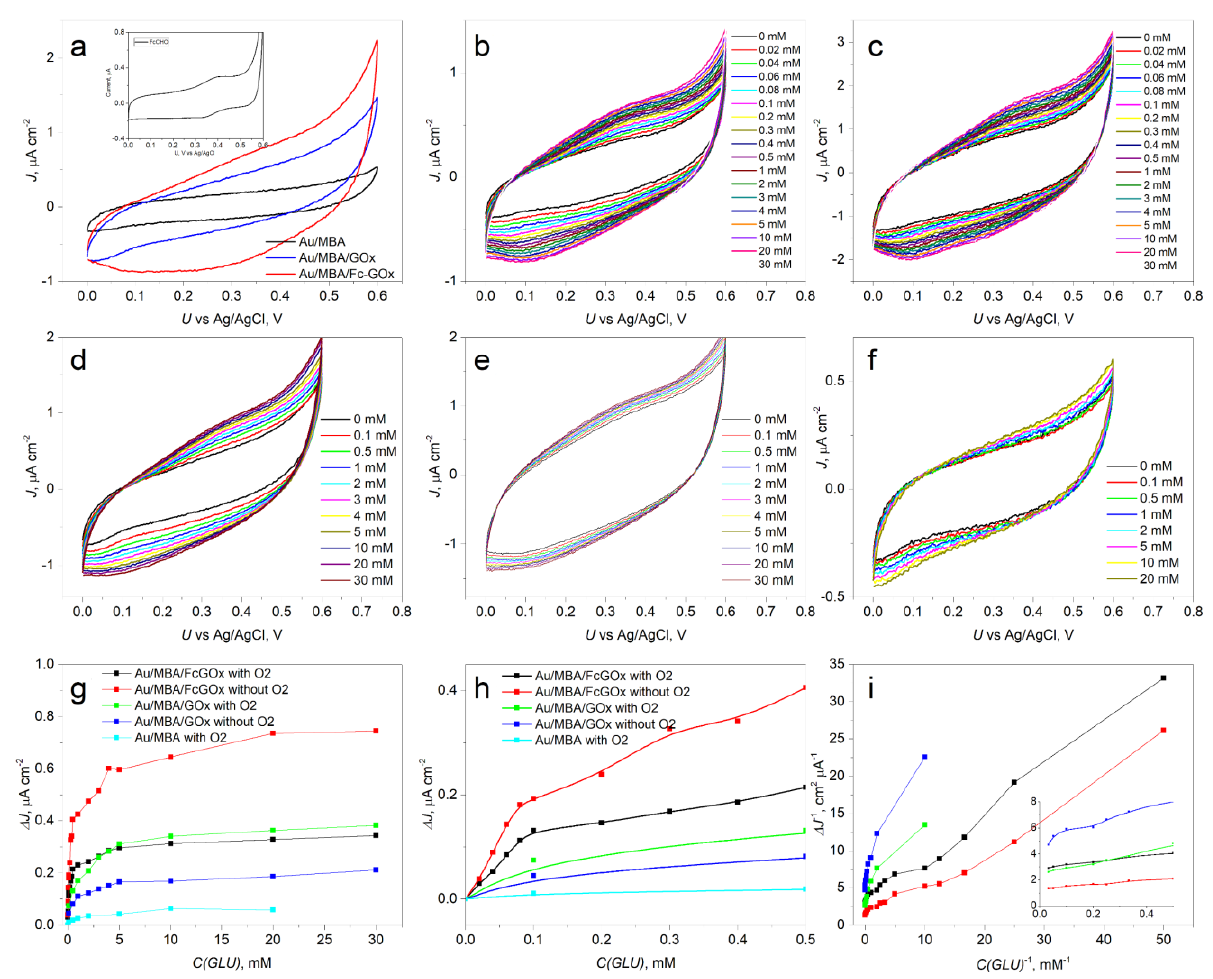
Figure 3. Electrochemical analysis of the GOx/MBA/Au and Fc-GOx/MBA/Au electrodes: ( a ) cyclic voltametric (CV) analysis of these electrodes in PPB pH 7.0 at 20 mV s − 1 (inset: CV of FcCHO in acetonitrile with Et 4 NBF 4 as a supporting electrolyte); ( b ) CVs of Fc-GOx/MBA/Au under varying glucose concentration presence atmospheric oxygen; ( c ) CVs of Fc-GOx/MBA/Au in PPB without oxygen; ( d ) CVs of GOx/MBA/Au under varying glucose concentration presence atmospheric oxygen; ( e ) CVs of GOx/MBA/Au without oxygen; ( f ) CVs of MBA/Au under varying glucose concentration; ( g ) current densities responses on the concentrations of glucose at 0.3 V vs. Ag/AgCl; ( h ) the magnified responses from 0 to 0.5 mM of glucose; ( i ) Lineweaver – Burk linearity test of all these responses.